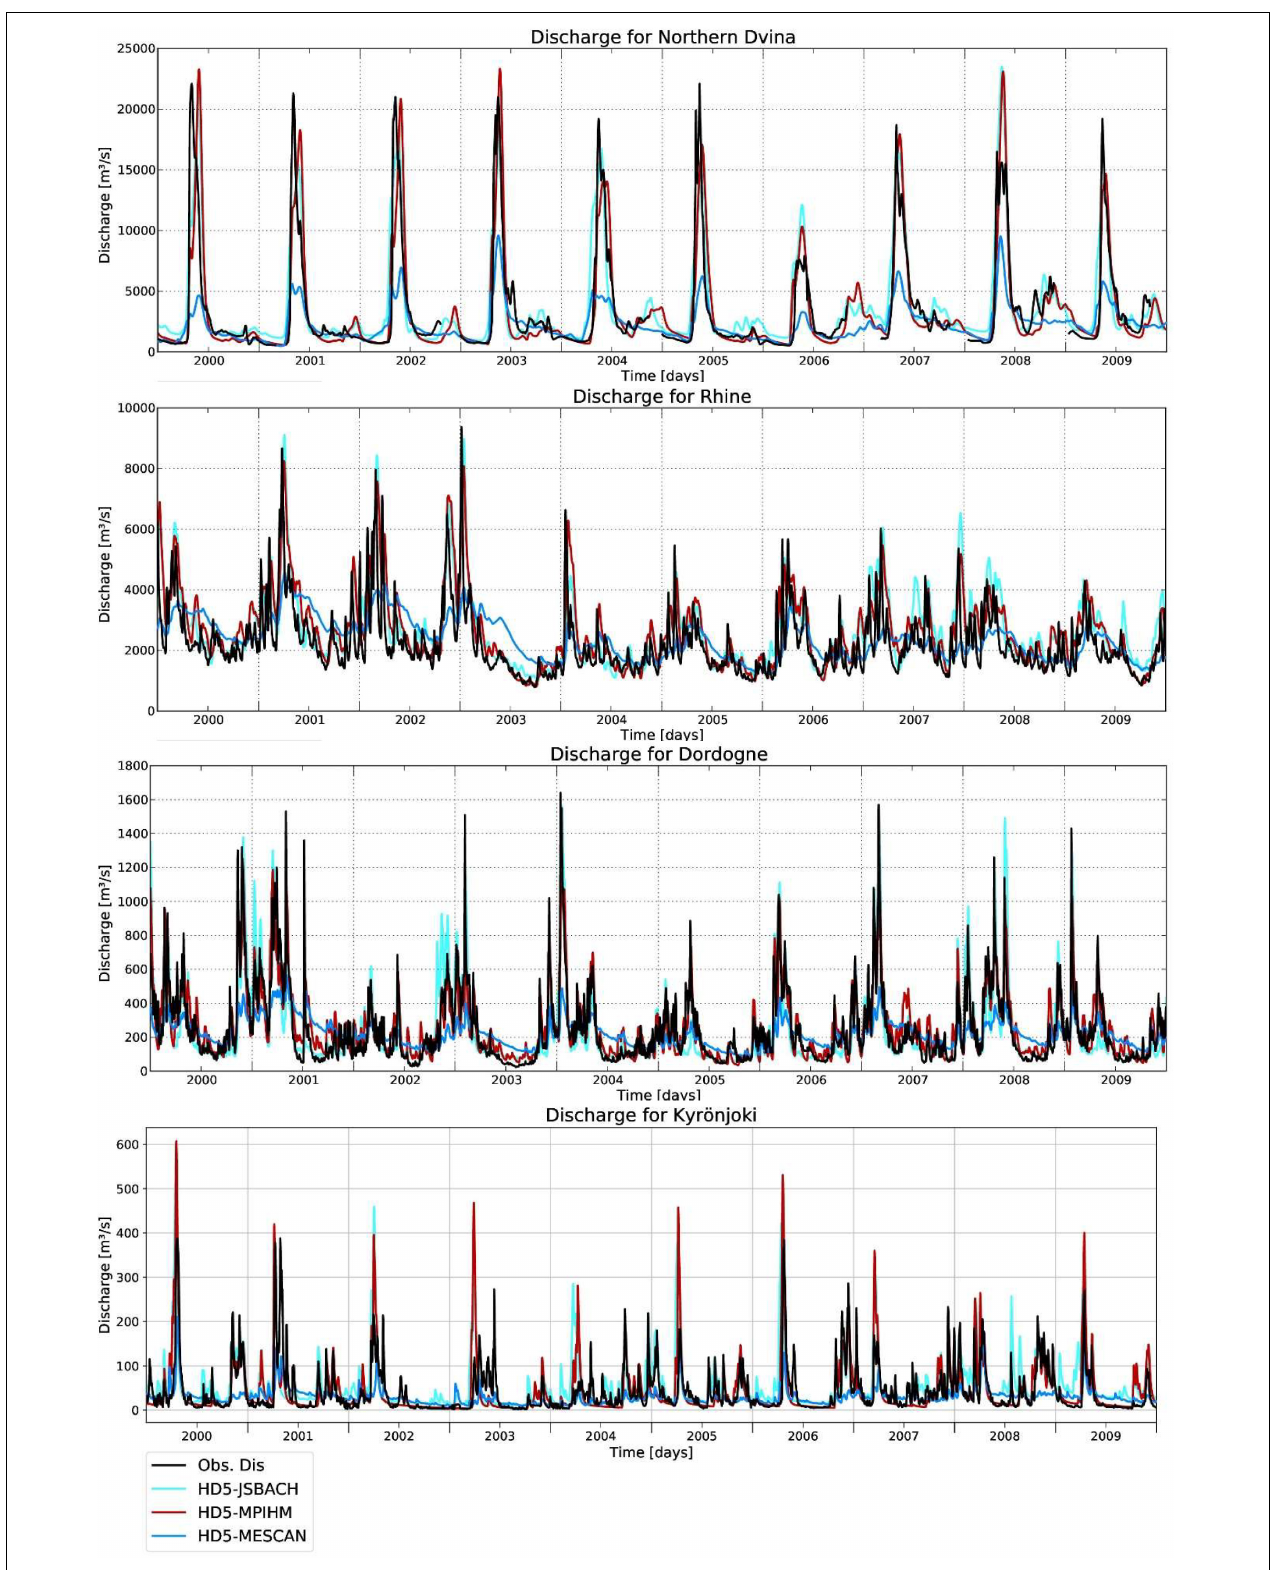
FIGURE 7 | Simulated and observed discharges from 2000–2009 for Northern Dvina (384000 km 2 ), Rhine (160800 km 2 ), Dordogne (14925 km 2 ) and Kyrönjoki (4833 km 2 ). The maximum KGE values are yielded by HD5-MPIHM and are 0.85, 0.70, 0.80, and 0.64, respectively.